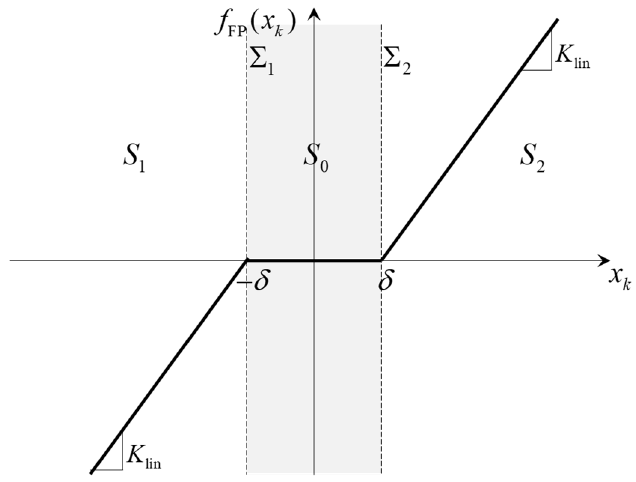
Figure 1. Illustration of freeplay and three subdomains separated by two freeplay boundaries in state space.